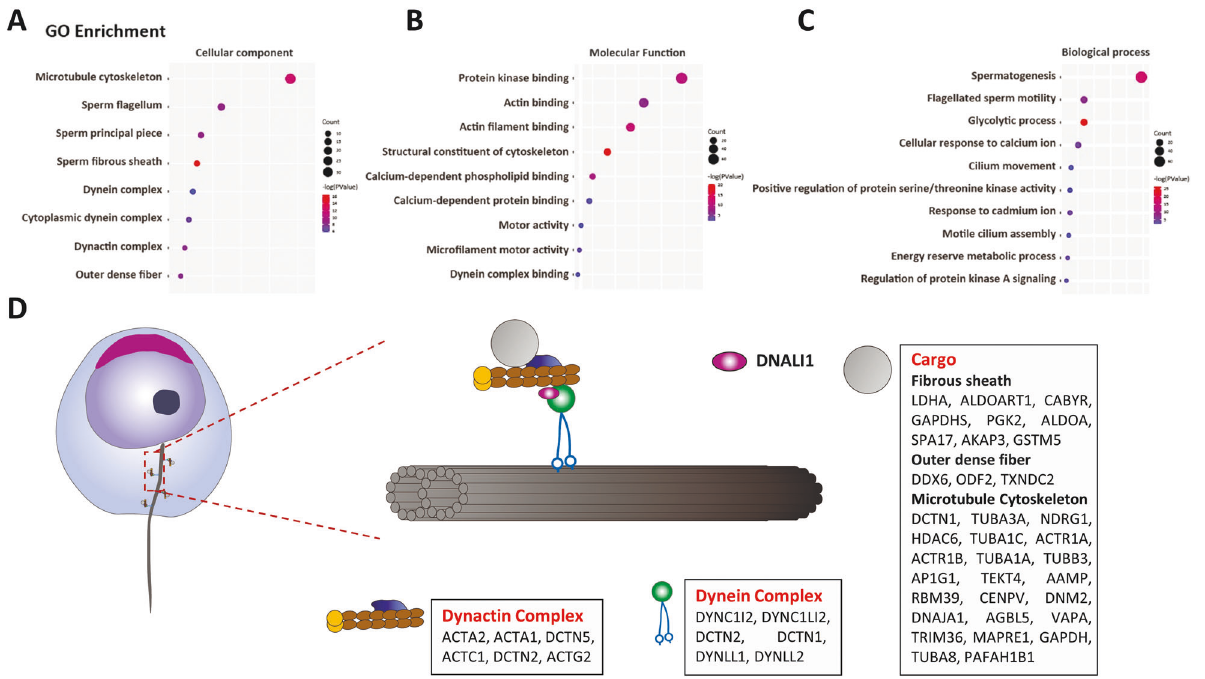
Fig. 6 DNALI1 may serve as a portion of the cytoplasmic dynein complex that regulates the transport and assembly of fl agellar components. A – C GO analysis of the DNALI1 binding proteins in mice testes. D A schematic of the cellular distributions of the DNALI1 binding proteins. The DNALI1 binding proteins are enriched in the Dynactin and Dynein complexes. A large number of fl agellum component proteins are identi fi ed and may serve as cargos transmitted by the dynein